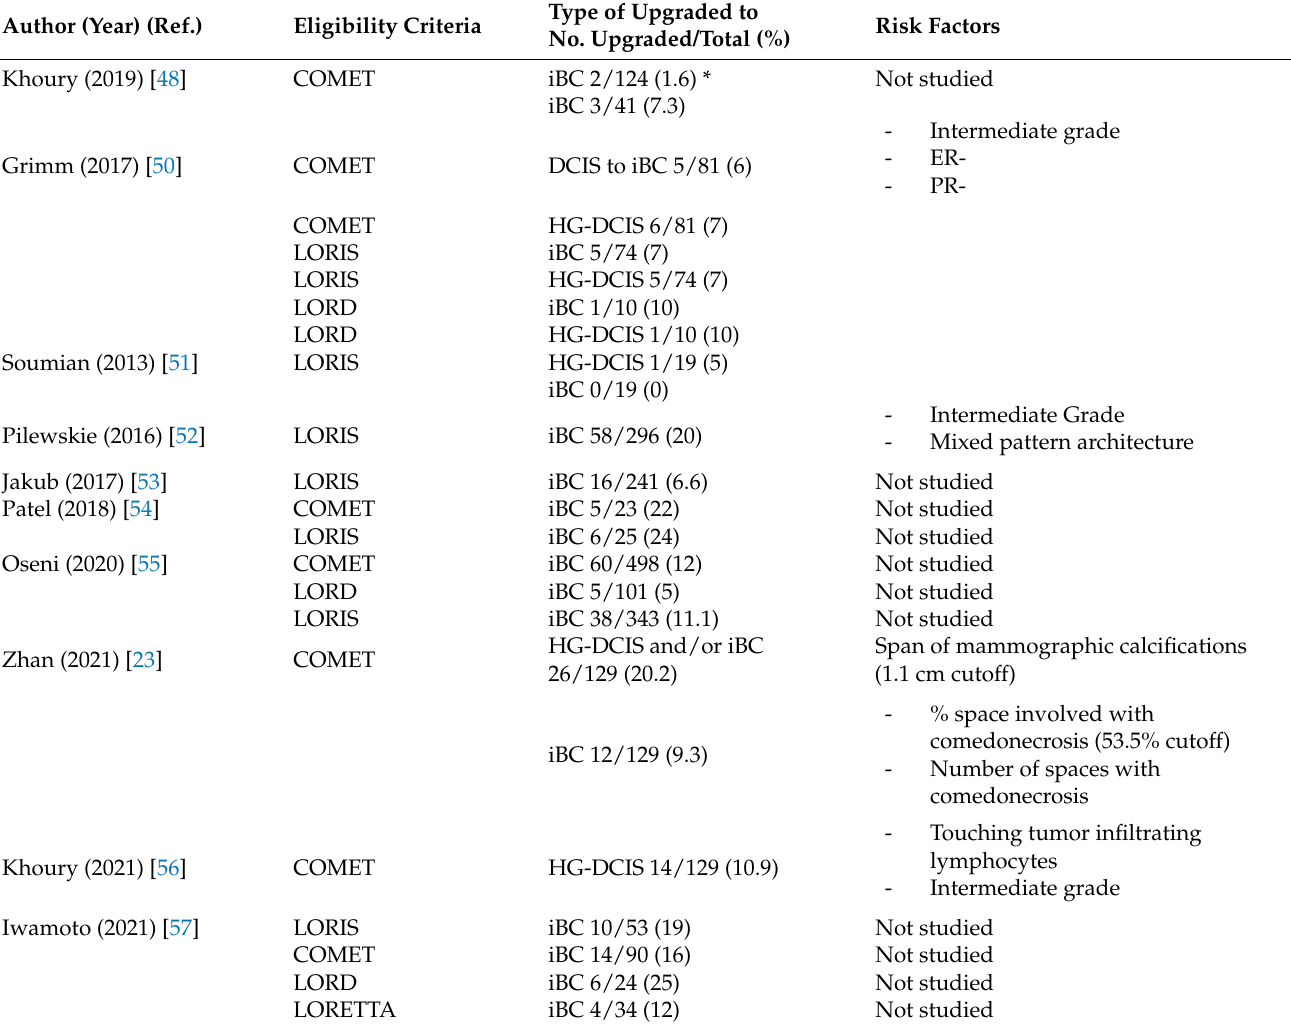
Table 2. List of studies simulating active surveillance trials for ADH or low-risk